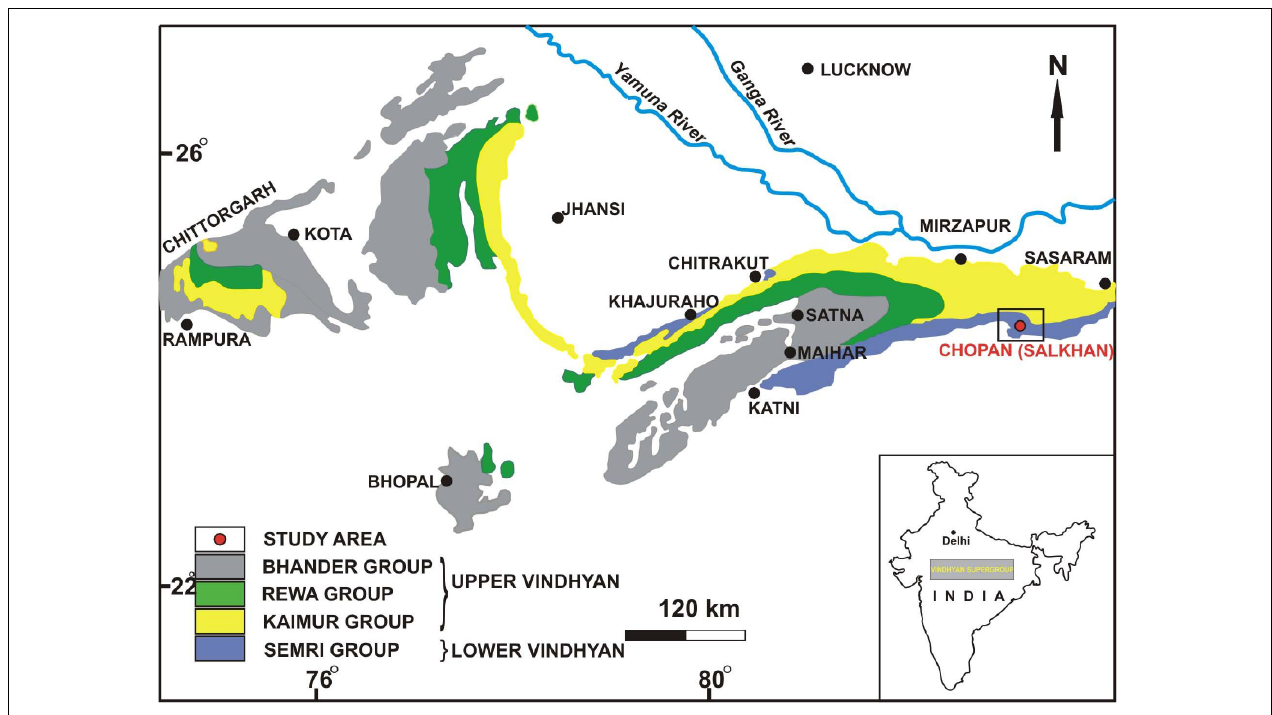
FIGURE 1 | Generalized geological map of Vindhyan Basin, inset map of India showing position of the Vindhyan Supergroup (after Krishnan and Swaminath, 1959).